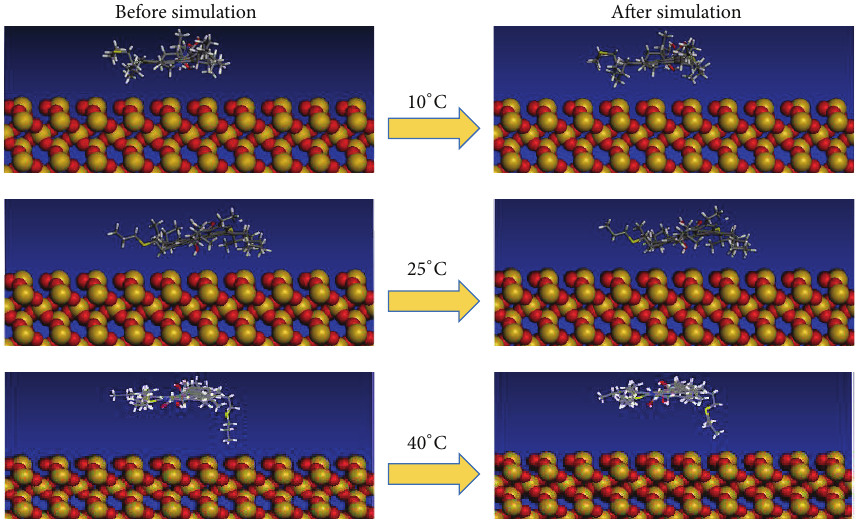
Figure 8: The interface configuration of asphaltene/SiO 2 (10–40 ∘